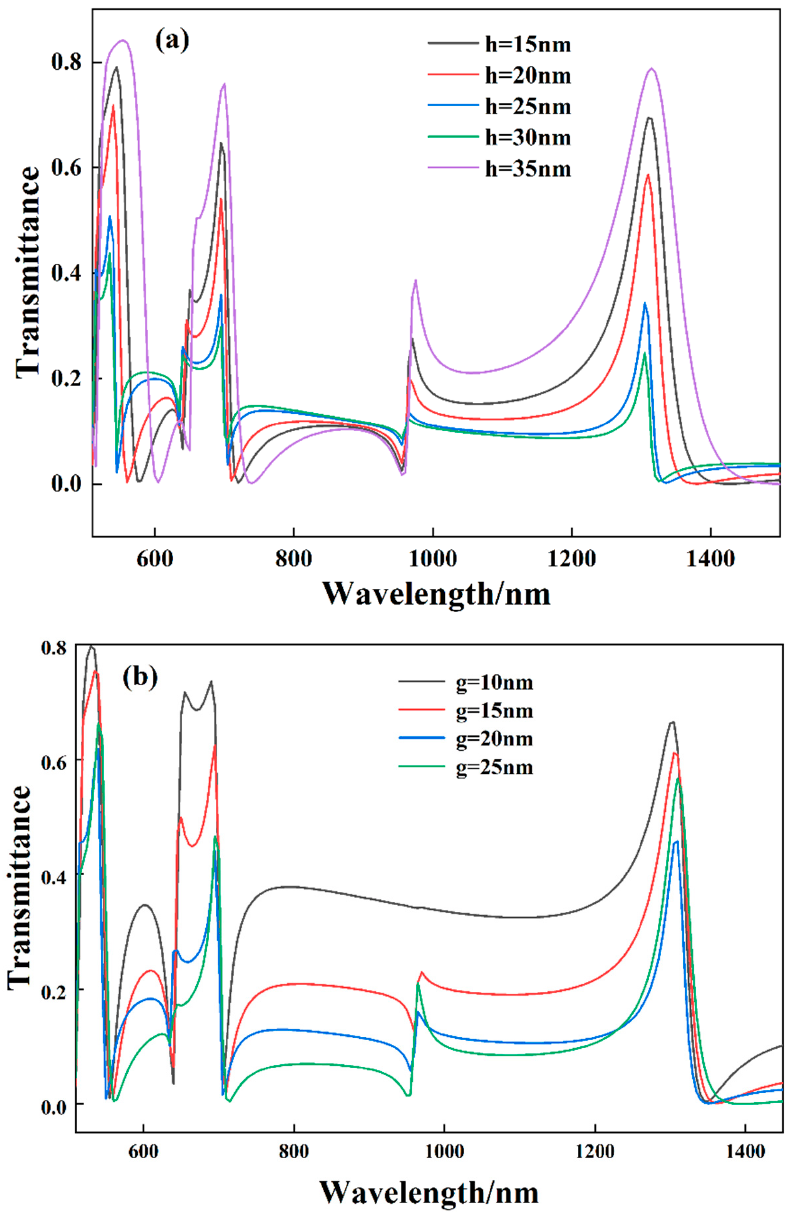
Figure 6. ( a ) Influences of different coupling heights between modes on structural Fano resonances. ( b ) Effect of different silver baffle widths on structural Fano resonances.